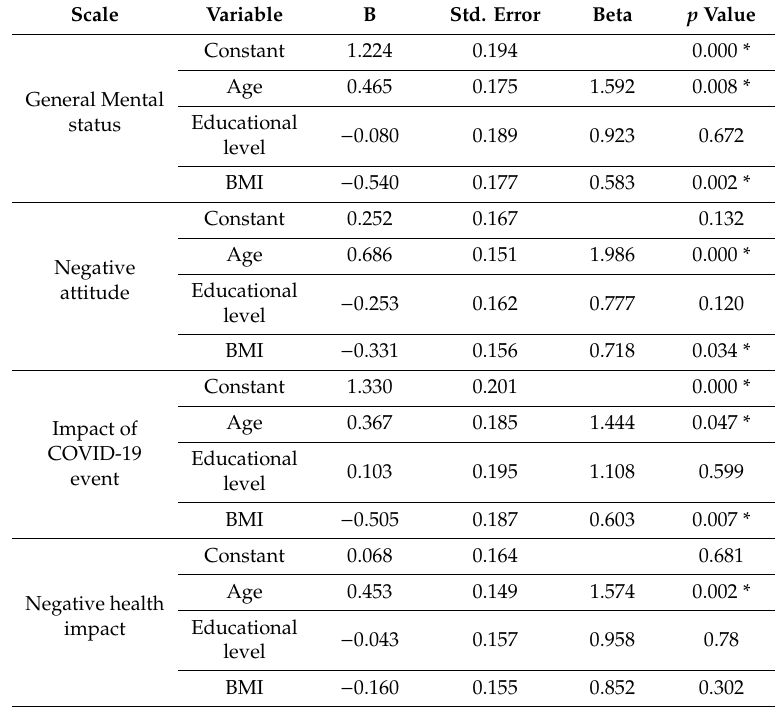
Table 5. Multiple linear regression